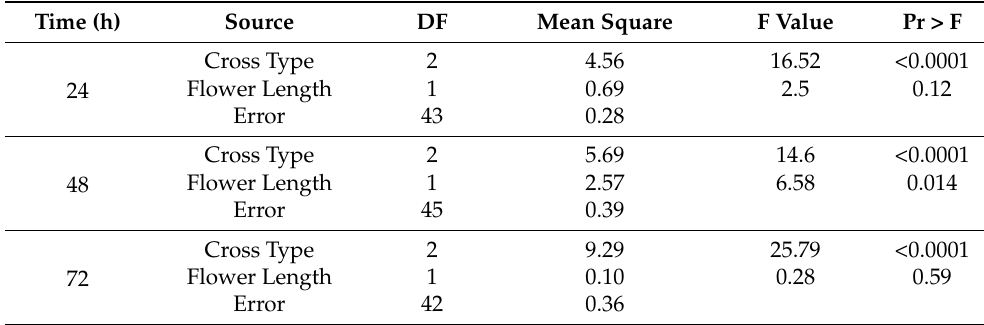
Table 6. Analysis of covariance for sources of variation in pollen tube length for cross type (intraspe- cific, interspecific, or self) between Osmanthus